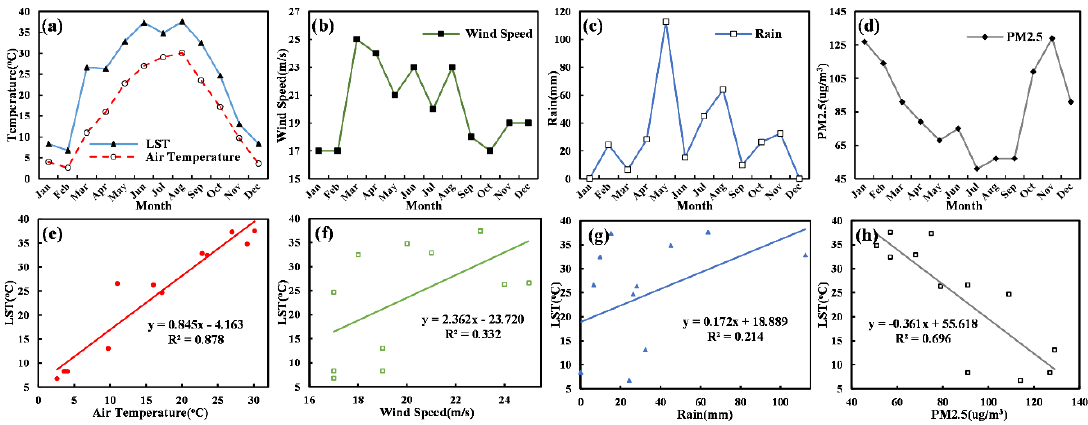
Figure 17. ( a )–( d ) represent monthly series trend of LST and air temperature, wind speed, rain, and PM2.5; ( e )–( h ) represent correlation of air temperature-LST, wind speed-LST, rain-LST, and PM2.5-LST, respectively.